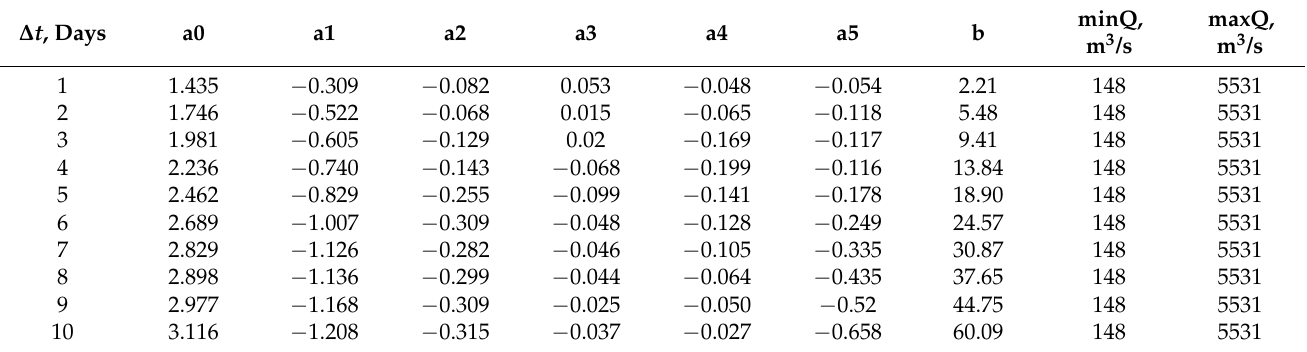
Table 1. Parameters of Formulas (3) and (4) for daily streamflow forecasting at gauging station Serafimovich on the Don